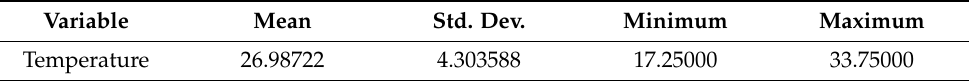
Table 1. The temperature data period is from 1 January 1989 to 31 December 2018. Variable Mean Std. Dev. Minimum Maximum Temperature 26.98722 4.303588 17.25000 33.75000